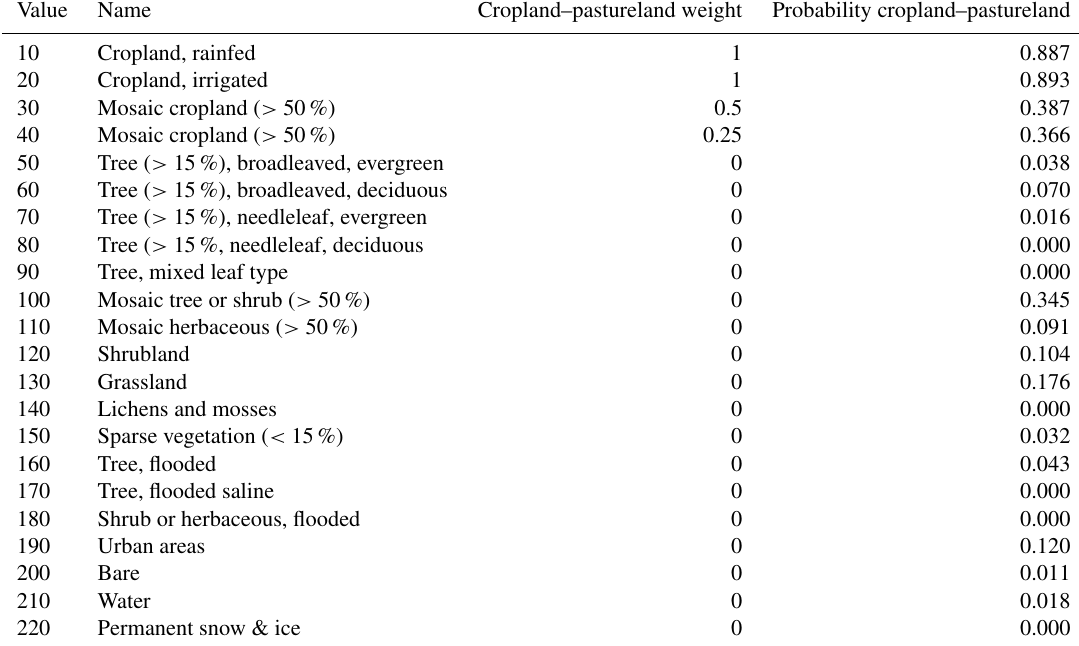
Table 3. Probability of a land cover type being classified as cropland or pasture, calculated using the producer’s accuracy, which is how often features on the ground are classified or the probability that a certain pixel is classified as a given land cover class. Probabilities of being cropland or pasture cover type ( C cp ) are adjusted based on patch size ( A ) for patches with A < 1km 2 , where p ( C cp ) = C cp · A 2 cp